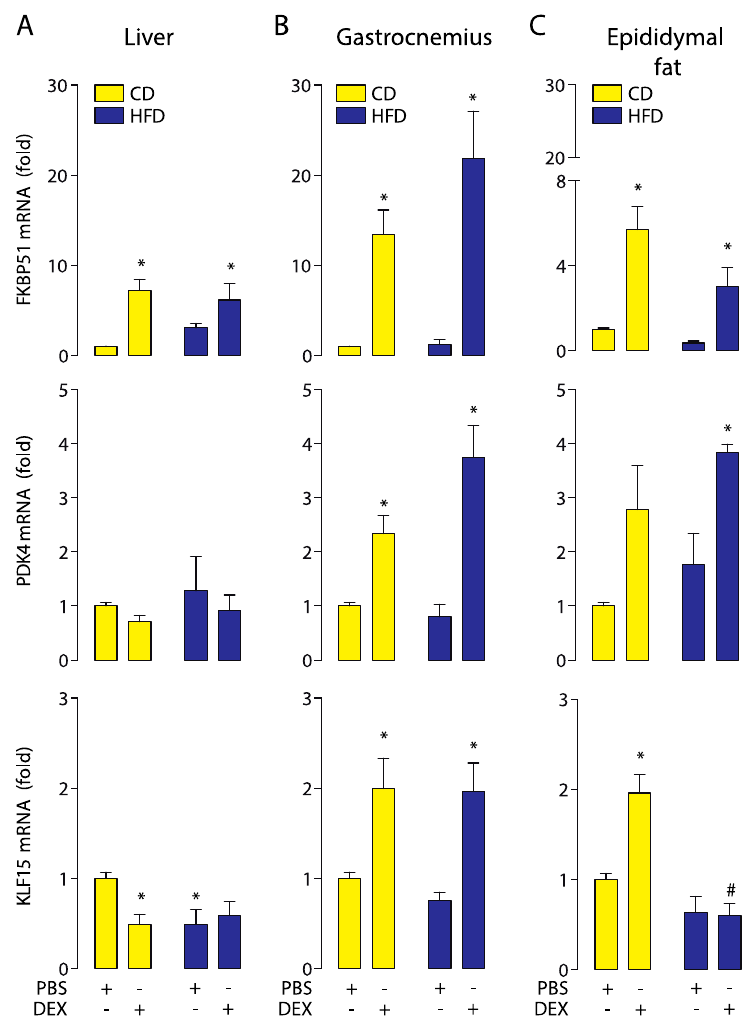
Figure 5. Moderate aerobic training prevented the hepatic GR hypersensitivity. FK506-binding protein 51 (FKBP51), pyruvate dehydrogenase kinase 4 (PDK4), and Krüppel-like factor 15 (KLF15) mRNA levels were determined by qPCR in the liver, gastrocnemius, and epididymal fat obtained from high-fat diet (HFD) or control diet (CD) mice subjected to moderate anaerobic training and treated with a dexamethasone injection (DEX; 2 mg/Kg i.p.) or phosphate-buffered saline (PBS). ( A ) mRNA expression in the liver. ( B ) mRNA expression in the gastrocnemius. ( C ) mRNA expression in epididymal fat. n = 6 mice per condition. Two-way analysis of variance (ANOVA) was conducted, followed by Tukey’s post hoc test. * p < 0.05 vs. CD + PBS, # p < 0.05 vs. CD + DEX. Values are expressed as mean ± standard error of mean.